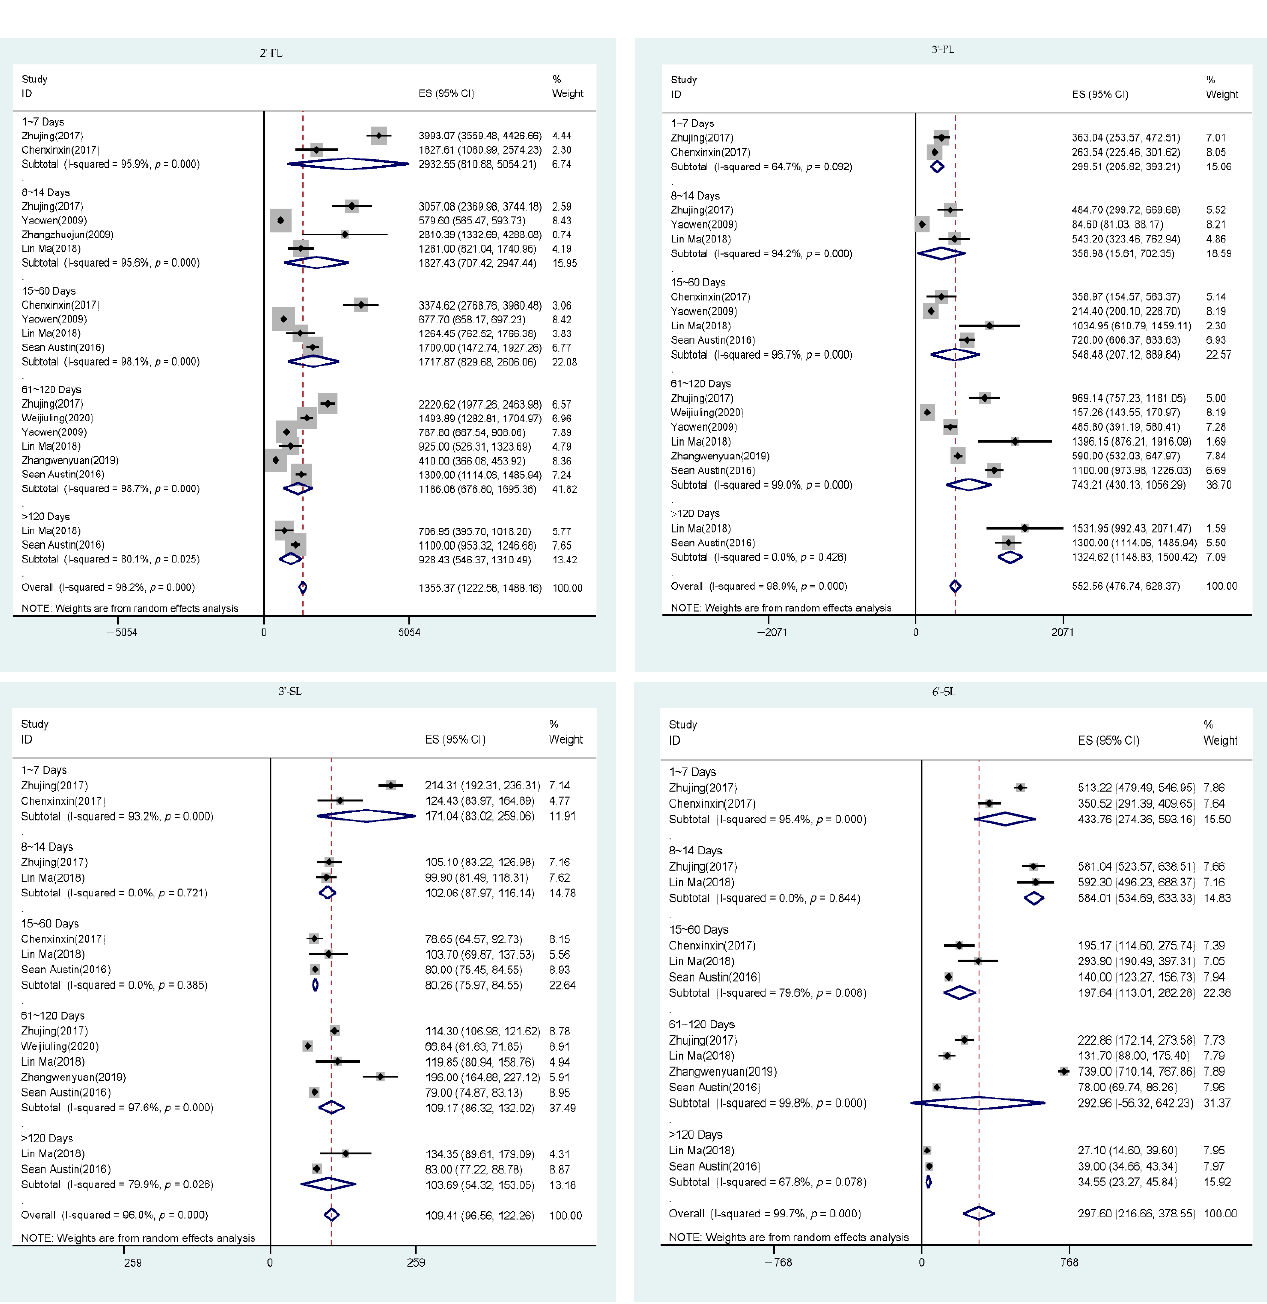
Figure 2. Forest plot of comparison of HMO concentrations.